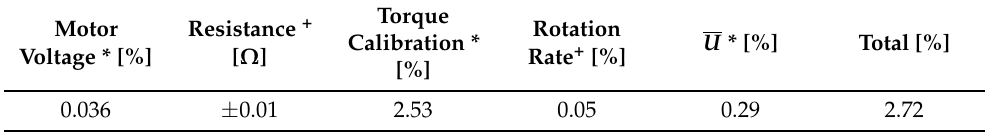
Table 1. An example of the components and total random error in calculating a turbine’s coefficient of power. * indicates that the error is derived from a bootstrap method, and + indicates that it was